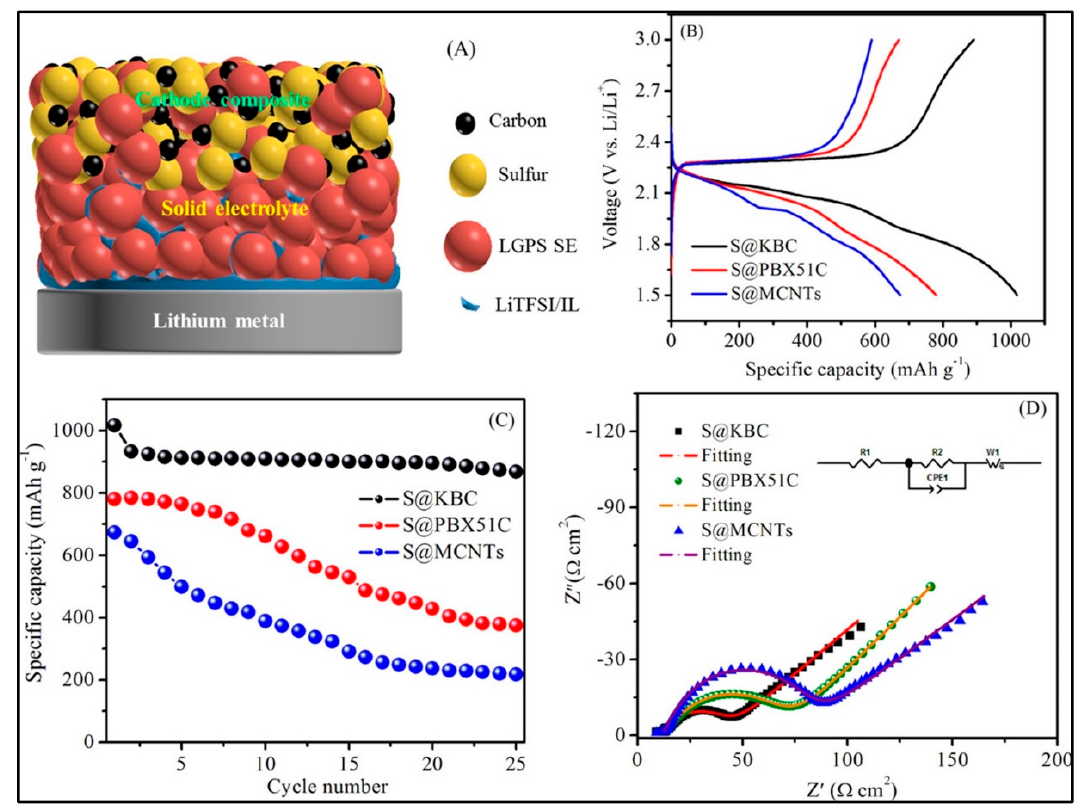
Figure 8. ( A ) The schematic representation of the quasi-solid-state lithium–sulfur cell comprising AB cathode, LGPS solid electrolyte and lithium metal as the anode; ( B ) first galvanostatic charge/discharge curves for different S@C composite cathode at current rate 83.5 mAg − 1 ; ( C ) the specific discharge capacity versus number of cycles of Li-S cell with various cathode; ( D ) the electrochemical impedance spectroscopy of the Li-S cell with various cathodes. (Reprinted with